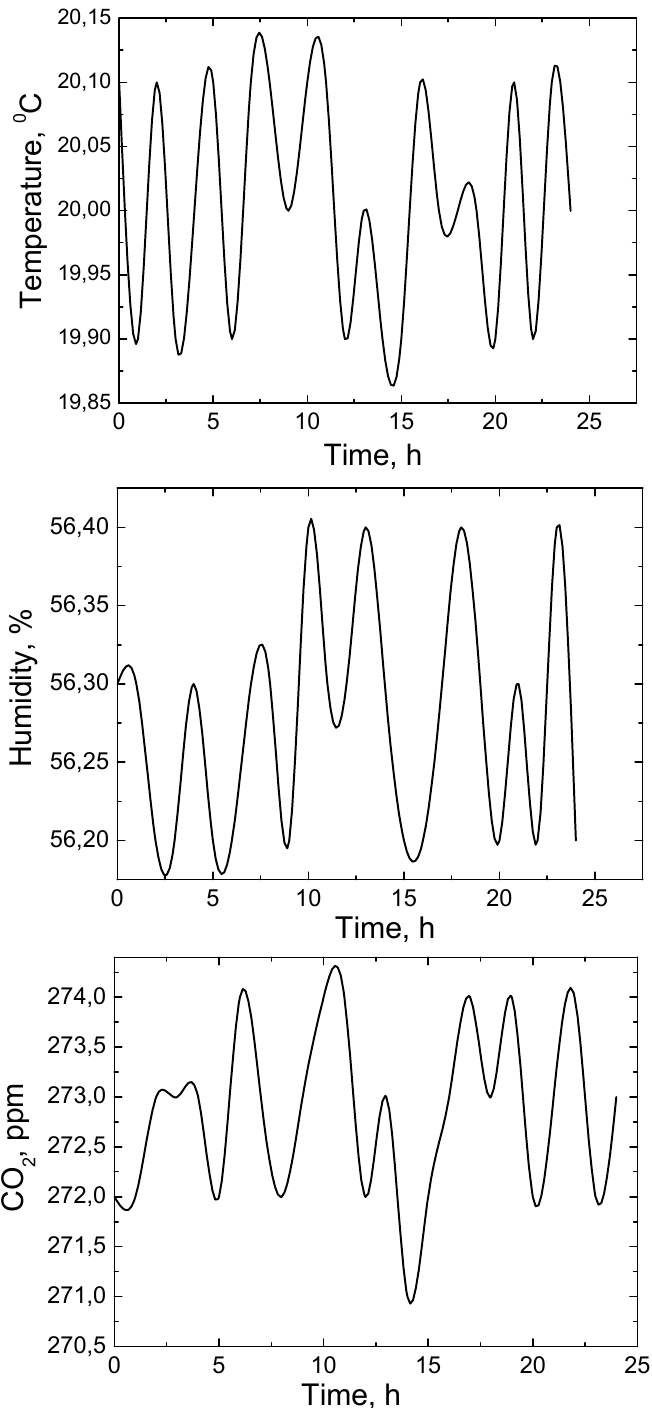
Figure 12. Changes in temperature, humidity and CO 2 in a mushroom growing room over a 24 h period.